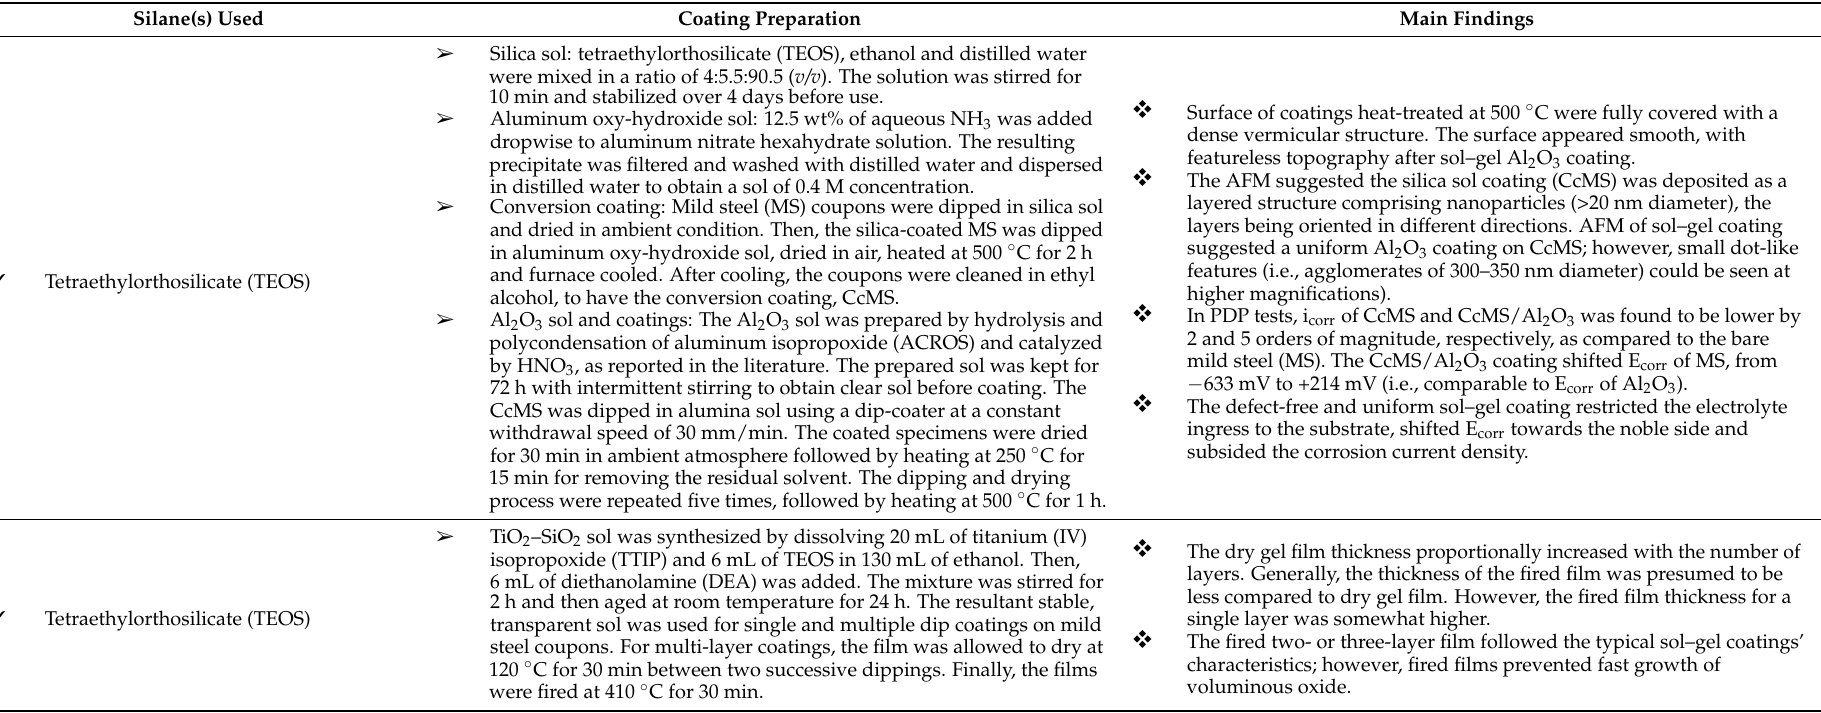
Table 1. Different approaches for improving silane coatings and the main findings, as reported in the literature. Silane(s) Used Coating Preparation Main Findings